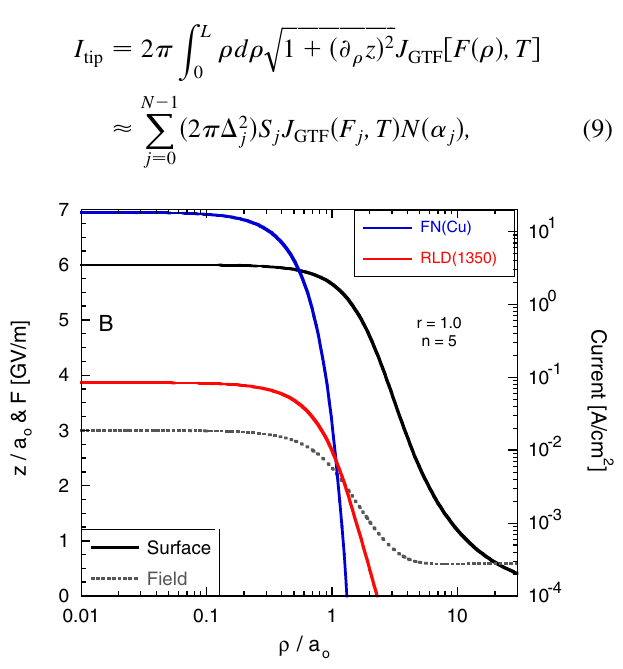
FIG. 10. (Color) Same as Fig. 9, but for r (cid:2) 1 for the same apex field. Field emission dominates over a much greater portion of the apex.